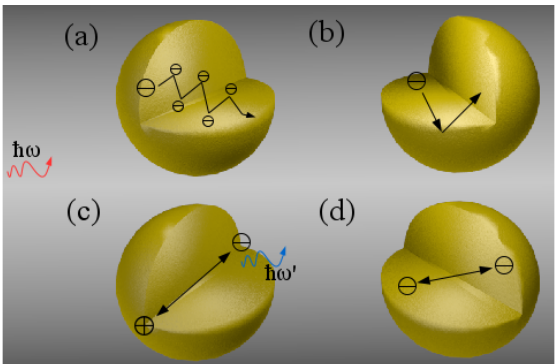
Figure 1. Illustration of sources of plasmon damping and electron interaction phenomena. ( a ) Electron- electron collisions in the bulk material; ( b ) Electron-surface collisions due to confinement; ( c ) Electron irradiation due to acceleration during plasmon oscillation; ( d ) Short-ranged electron-electron interactions, such as Coulomb force and electron